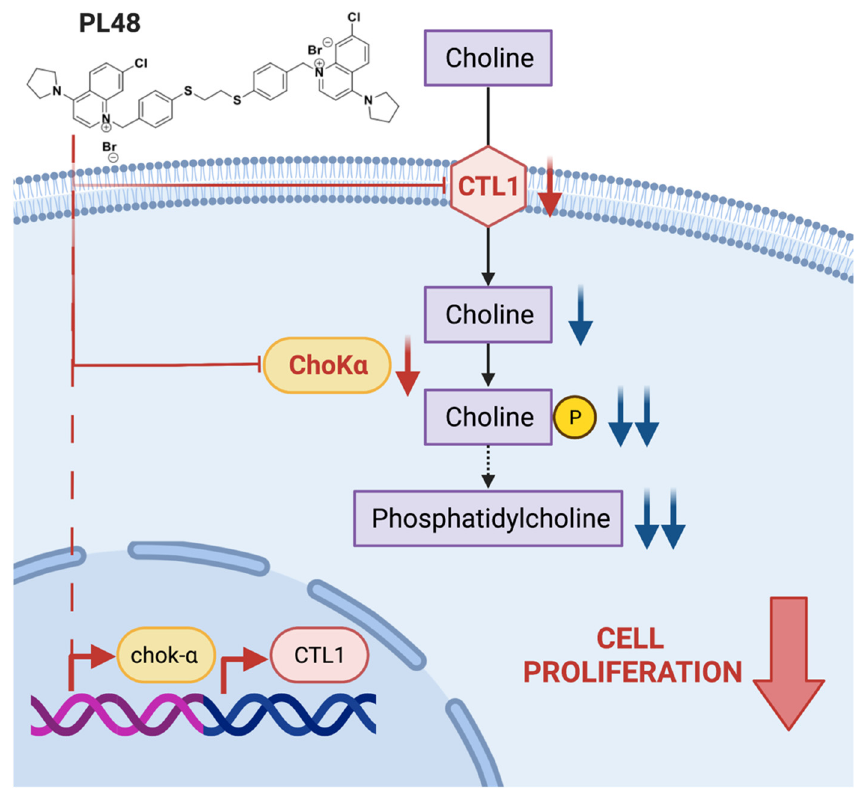
Figure 10. Scheme showing the action of PL48.